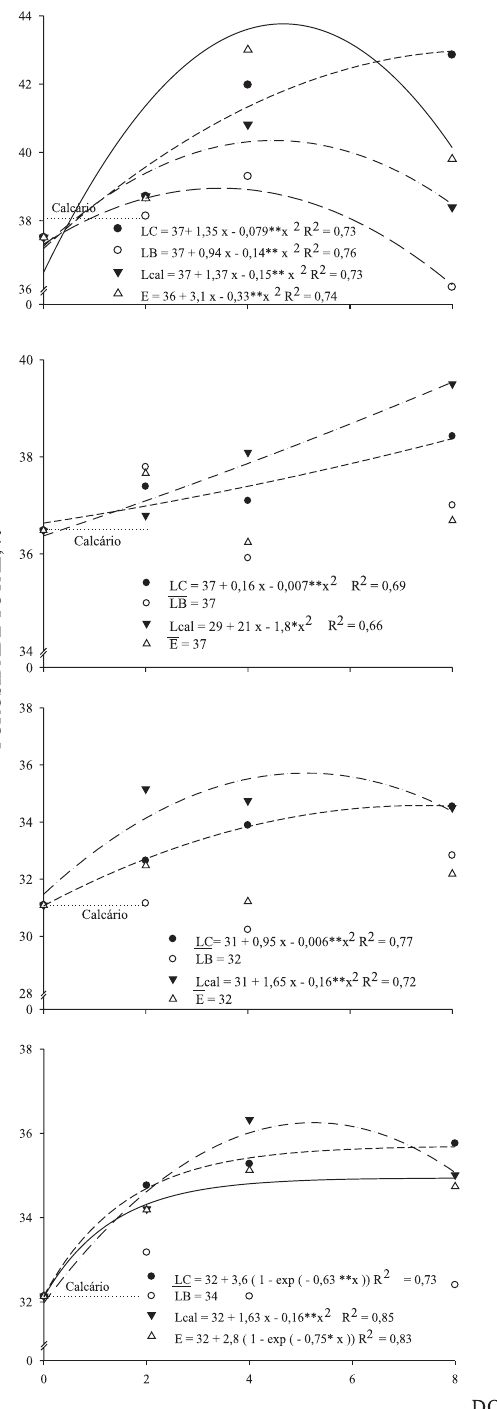
Figura 4. Porosidade total e retenção de água em função da aplicação dos resíduos e calcário aos 27 meses após a aplicação. As siglas E, LB, LC e Lcal são escória de aciaria, lodo de esgoto de biodigestor, lodo de esgoto centrifugado e lama cal,